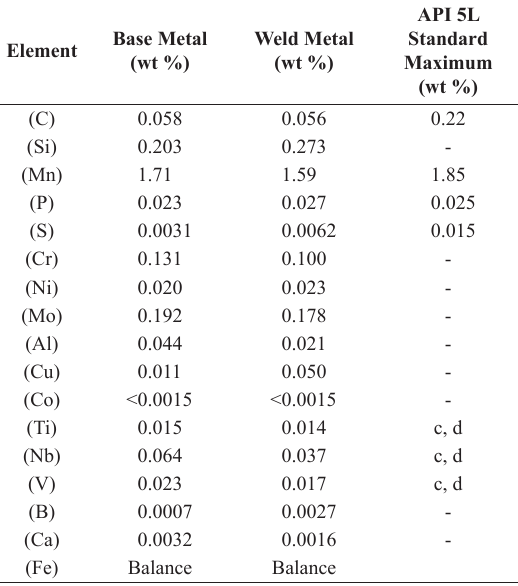
Figure 2. Sampling regions for chemical composition using optical emission spectroscopy. Table 1. Chemical composition of the base metal and weld metal in wt%.